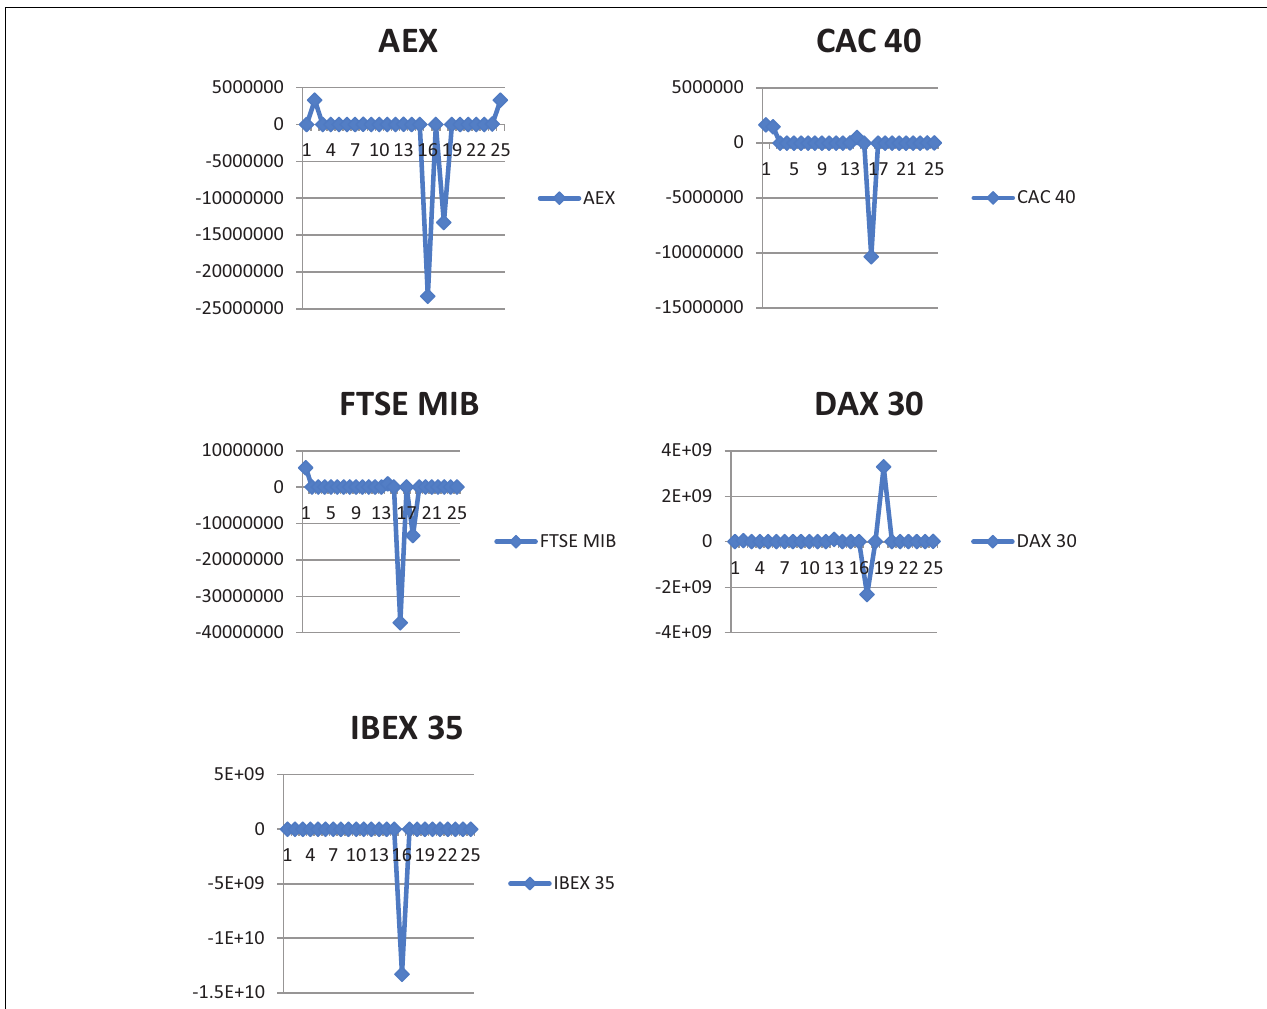
FIGURE 1 | Algorithmic trading system P&L for AEX, CAC 40, DAX 30, IBEX 35, and FTSE MIB.